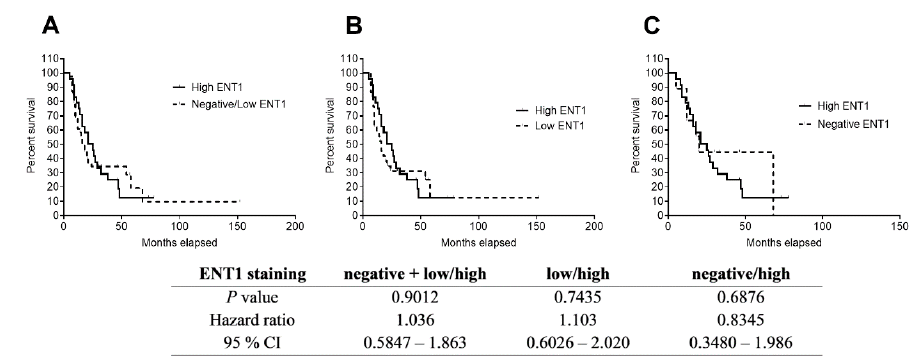
Figure 4. Kaplan–Meier curves showing differences in DSS based on immunohistochemical expression of ENT1. Patients ( n = 63) were divided according to histoscore (see Methods section) into three groups with negative ( n = 9), low ( n = 30), and high ( n = 24) protein expression of ENT1. Statistical significance was evaluated by applying log-rank test analysis between subgroups with ( A ) high and negative / low ENT1 expression, ( B ) subgroups with high and low ENT1 expression, and ( C ) subgroups with high and negative ENT1 expression. No significant association of ENT1 expression with patients’ DSS was